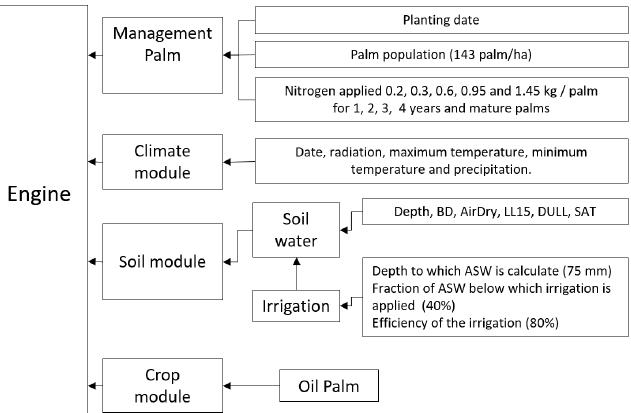
Figure 2. Flow diagram of the different modules of the APSIM simulation process.